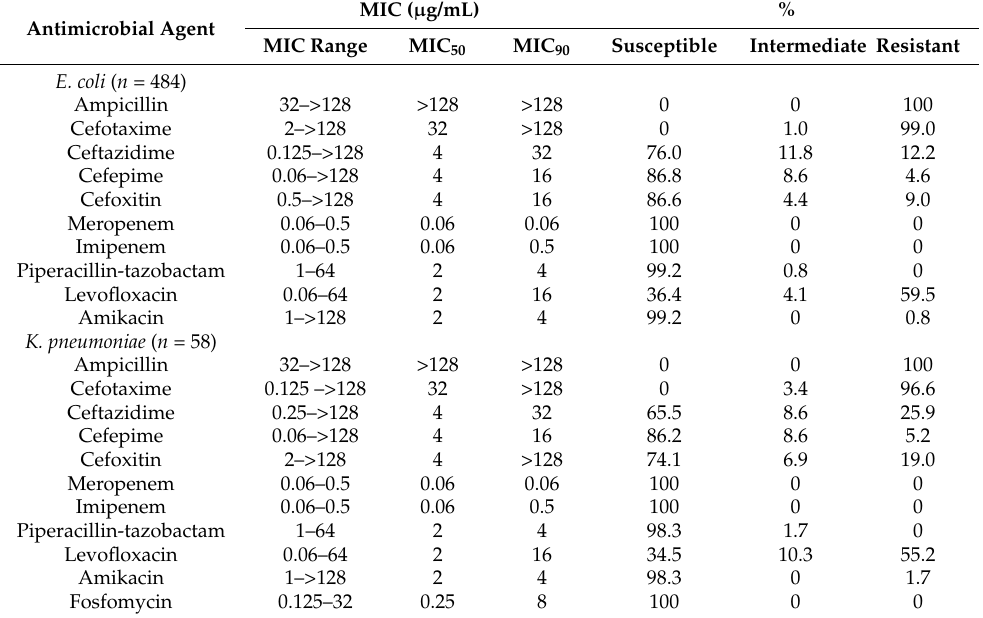
Table 1. Antimicrobial susceptibility of the intestinal colonizing ESBL-producing Escherichia coli and Klebsiella pneumoniae isolates collected from elderly study participants.